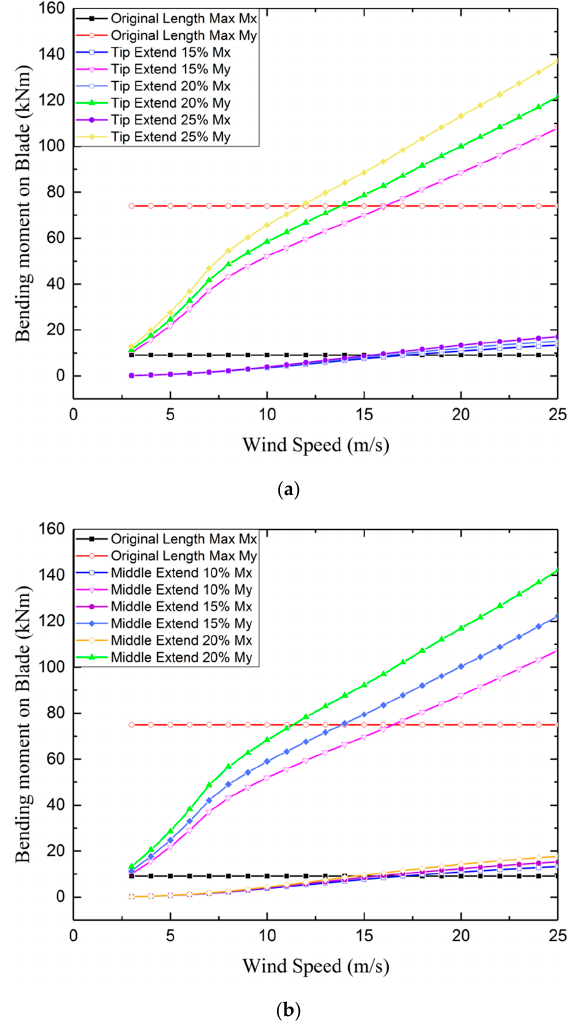
Figure 8. ( a ) Determination of the wind speed range for ( a ) blade extension at tip and ( b ) blade extension in the middle.